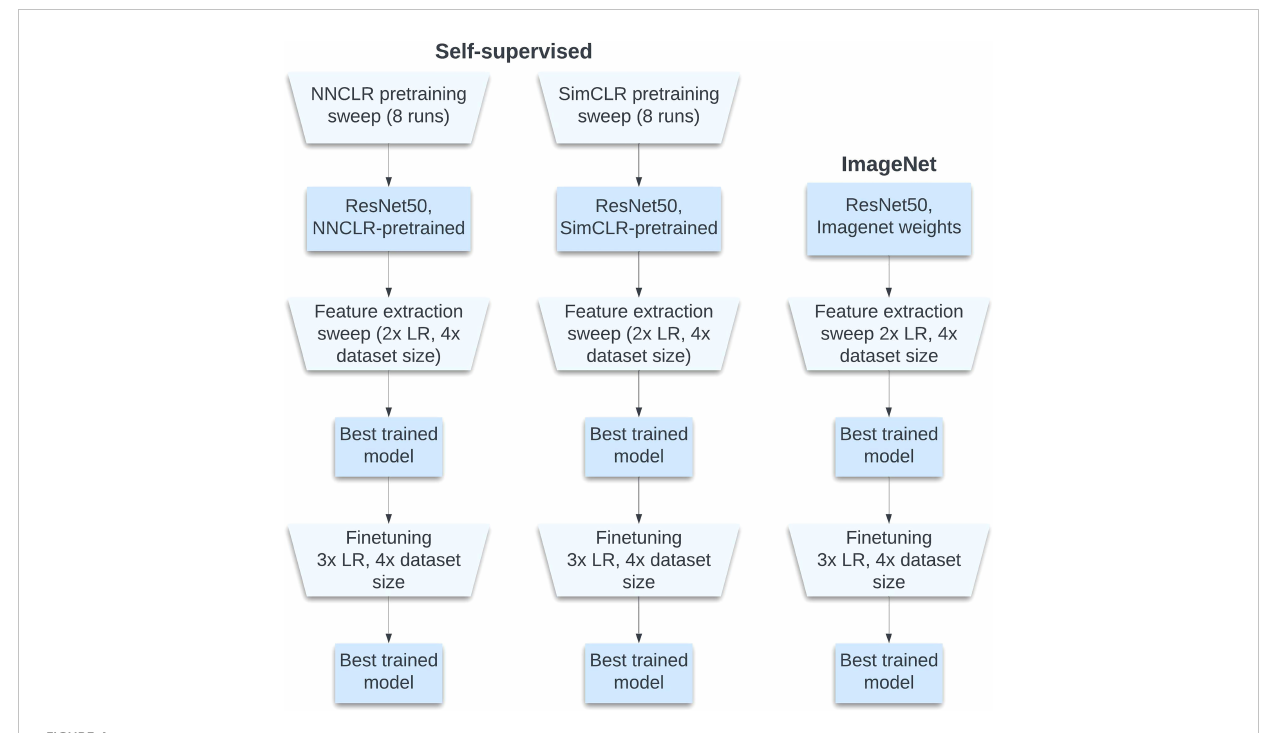
FIGURE 4 Training process. With each sweep over hyperparameters, the best model is chosen for the next